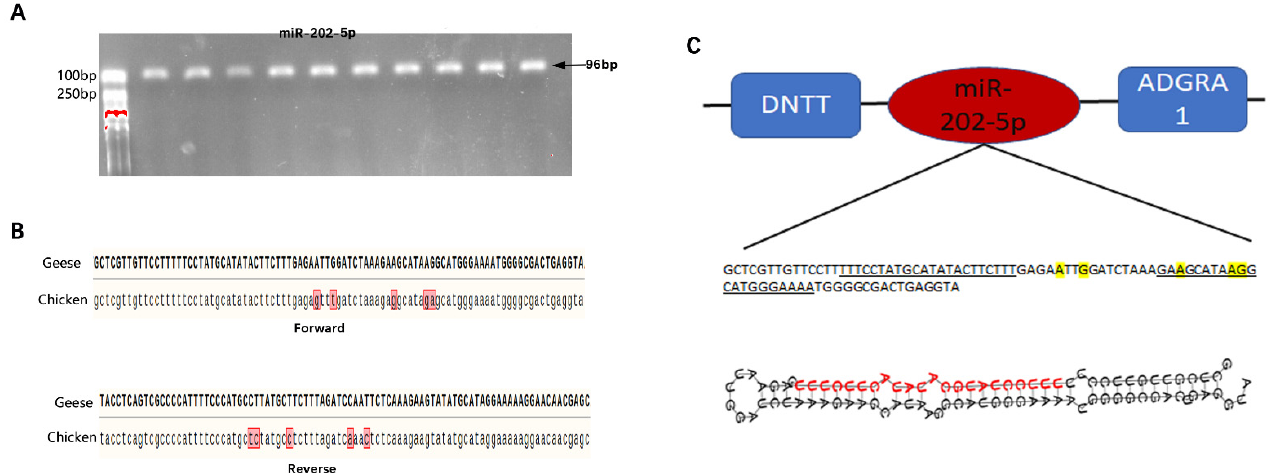
Figure 1. Sequence characteristics of the goose miR-202-5p precursor. ( A ) goose miR-202-5p precursor, ( B ) comparation of the miR-202-5p precursor between goose and chicken, and ( C ) genomic alignment and secondary structure prediction of goose miR-202-5p precursor.